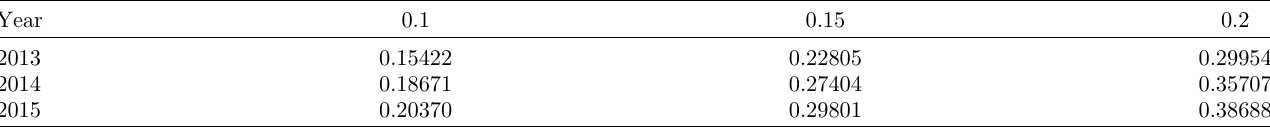
Table 8. Prob ð U 1 (cid:6) u j U 2 2 ½ 0 : 1 ; 0 : 2 (cid:2) ; U 3 2 ½ 0 : 1 ; 0 : 2 (cid:2)Þ – see equation (14) with